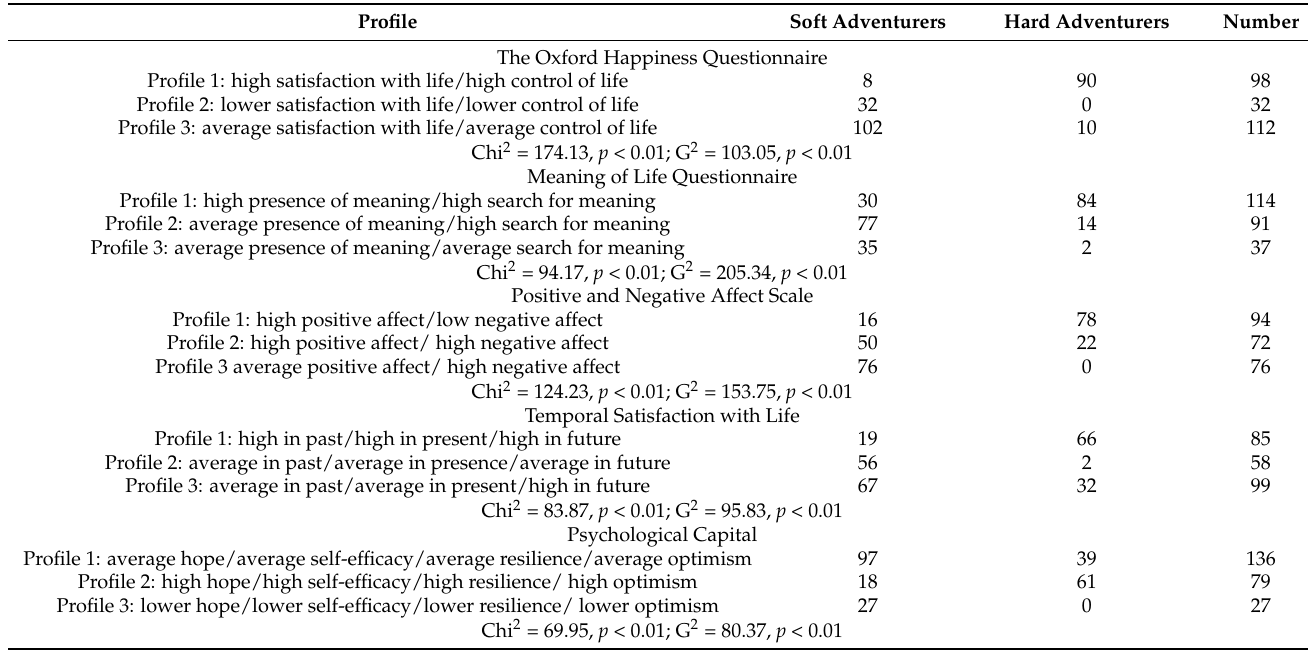
Table 6. Profiles of wellbeing in the group of soft and hard adventurers. Profile Soft